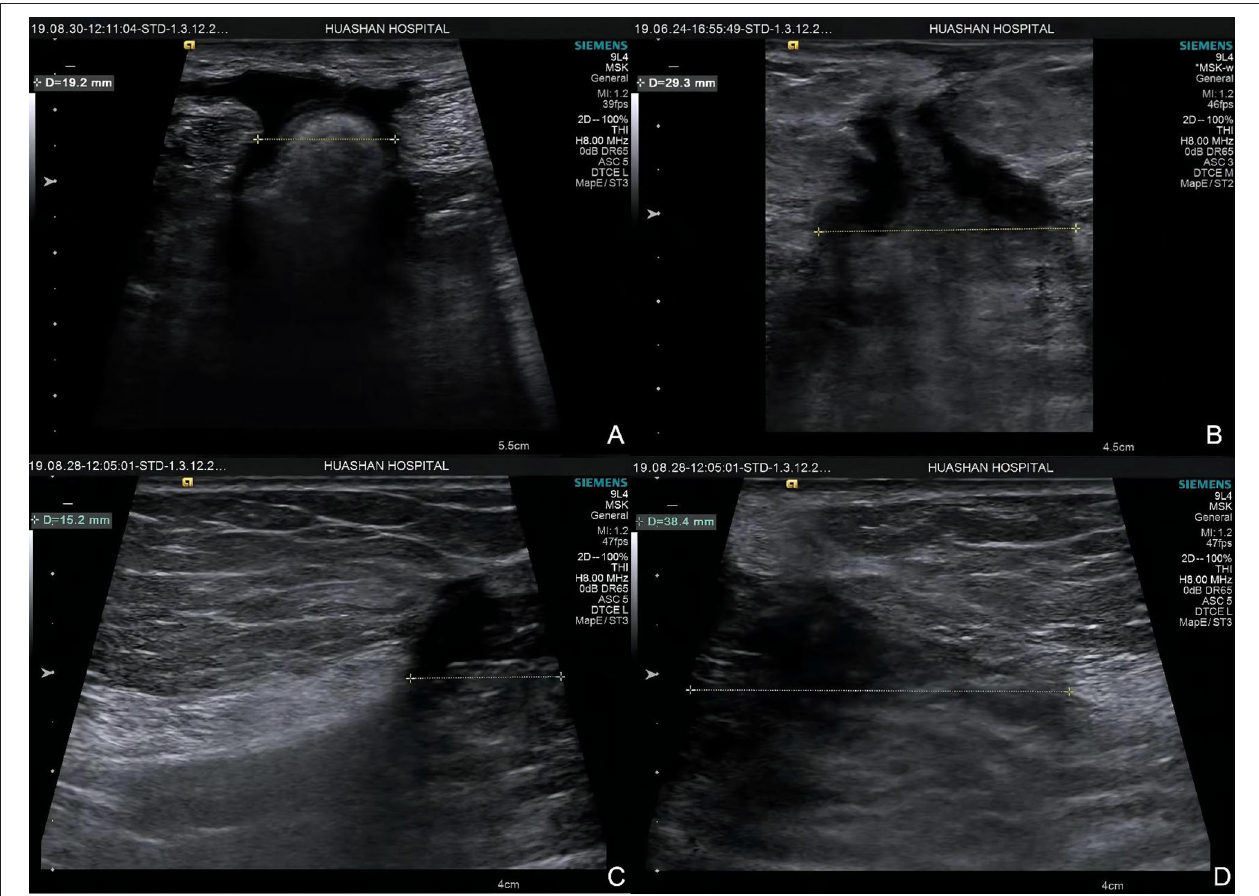
FIGURE 2 | Hernia width of two groups. Group A: (A) hernia width = 19.2mm; (B) hernia width = 29.3mm. Group B (C,D) : hernia width = 15.2 + 38.4 = 53.6mm.